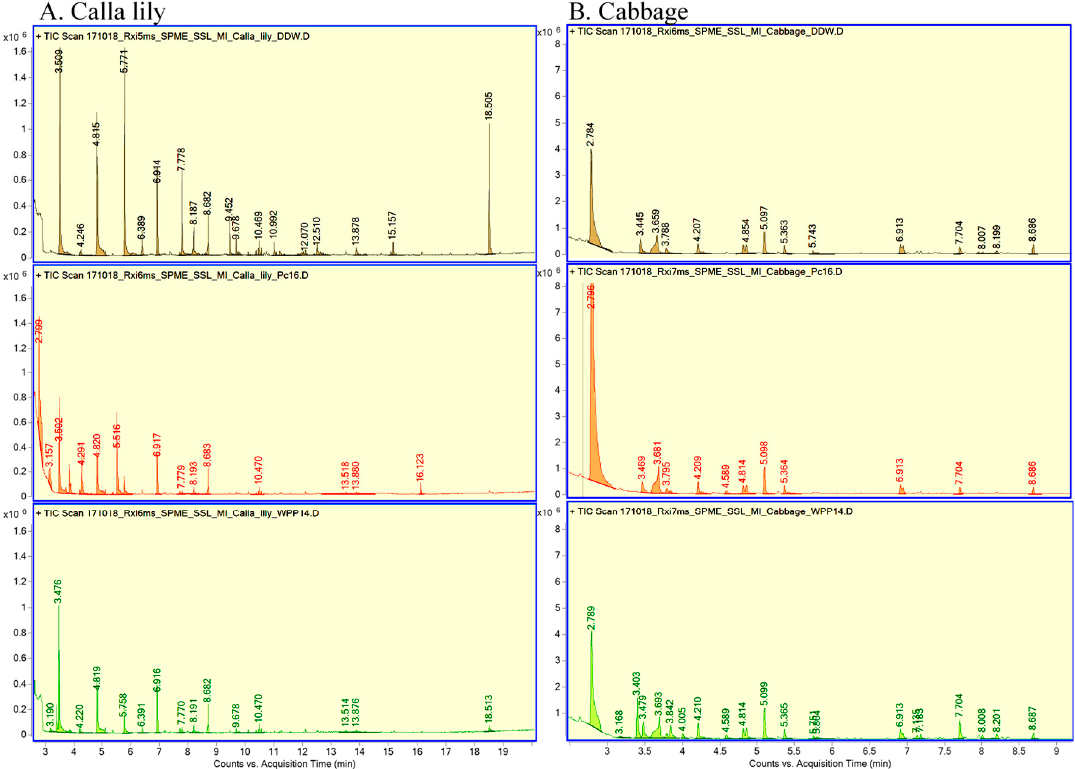
Figure 3. Chromatograms of volatile organic compounds (VOCs) produced by leaf samples, ( A ) calla lily and ( B ) cabbage samples (double-distilled water (DDW)-black, Pc16- red, WPP14-green), following infiltration with bacteria, and incubation in airtight jars at 28 °C for 24 h, and adsorption onto a SPME fiber. The adsorbed compounds were analyzed using Agilent GC 7890A and 5975C MSD, and mass spectra were acquired in positive electron-impact (EI) scan mode (m/z 20–350). Identification of the VOCs was performed by comparing their mass spectra and retention times with the NIST/EPA/NIH Mass Spectral Database (NIST 05, National Institute of Standards and Technology, Gaithersburg, MD, USA; see Tables 2 and 3). Representative chromatograms from two independent experiments are presented.